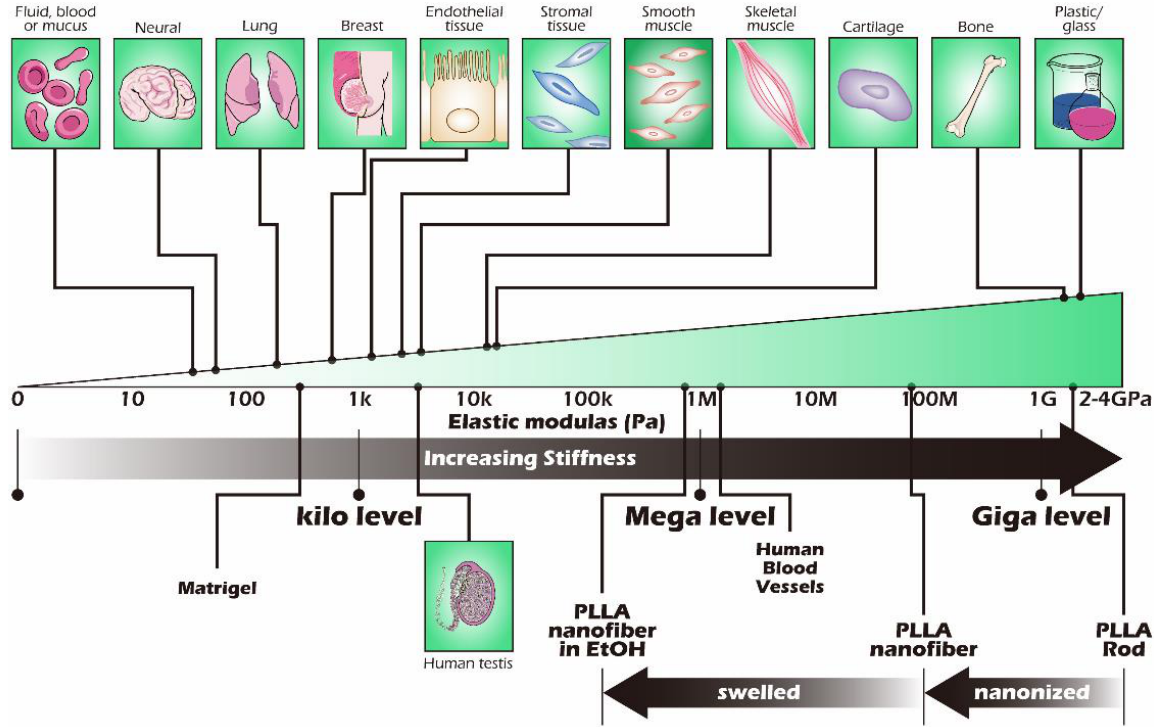
Figure 9. Biomechanical characteristics of mammalian tissues (variations in tissue stiffness). The biomechanical properties of tissue in terms of stiffness (elastic modulus) are usually measured in Pa. There are differences in stiffness between the organs and tissues, and this is closely related to tissue function in nature. Most of the soft tissues are lower than the kPa level, and the hard tissues are as high as the GPa level; the bioscaffold plays a key role as an extracellular matrix to create an environment similar to the original tissue to facilitate the reconstruction and regeneration of the native tissue. Reproductive system tissues are approximately 1–5 kPa. This schematic illustration was redrawn after referring to the paper by Thomas R. Cox and Janine T. Erler [21] and